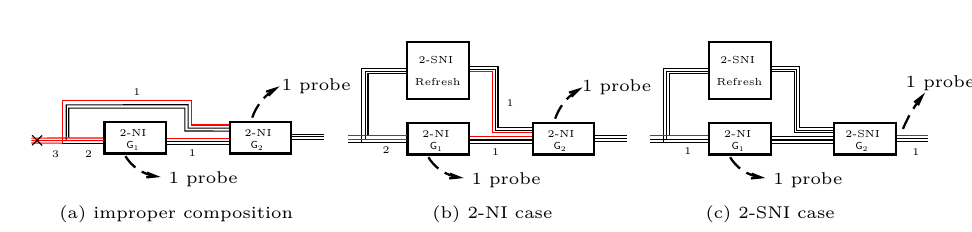
Figure 1: A simple example to illustrate the composability in Lemma 4 with 3 shares. Shares required for simulation are drawn in